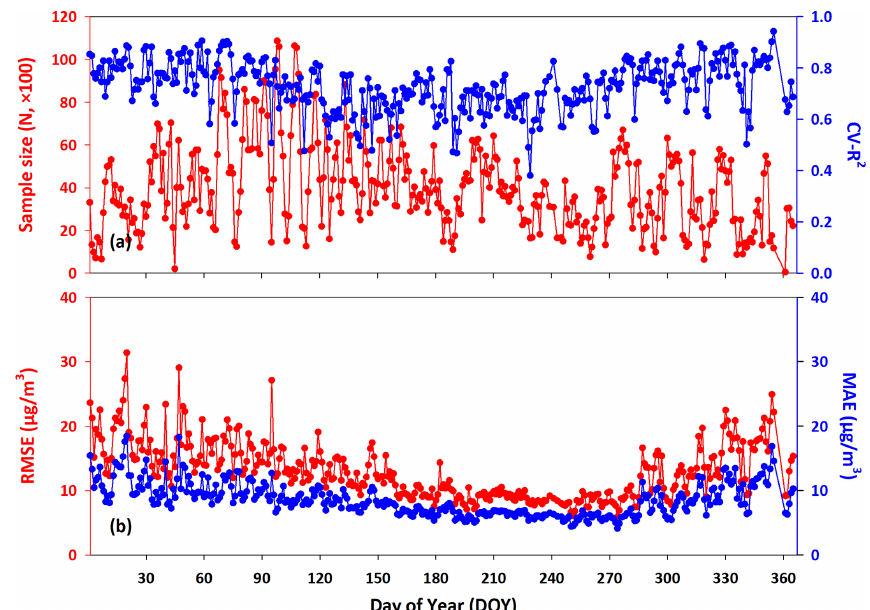
Figure 10. Time series of out-of-sample cross validation of hourly PM 2 . 5 estimates (µgm − 3 ) in terms of (a) the sample size ( N , red) and CV- R 2 (blue) and (b) RMSE (red) and MAE (blue) in 2018 in